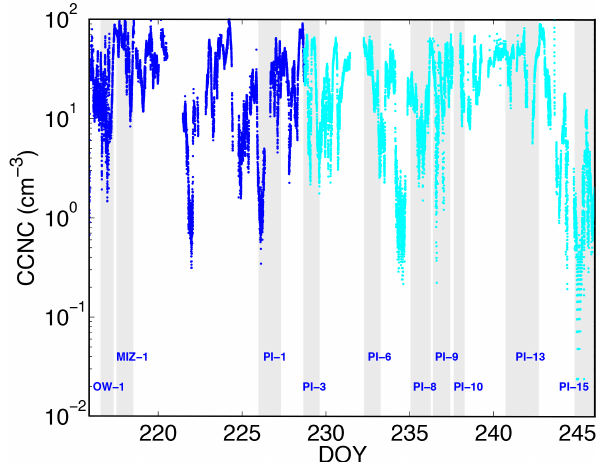
Figure 2. CCNC as a function of time in units of cm − 3 . Blue dots show CCNC measured at 0.17% water vapour SS; light blue dots show the CCNC at 0.21% water vapour SS. The grey bars mark the duration of each of the impactor samples. Details on impactor start and stop times are given in Table